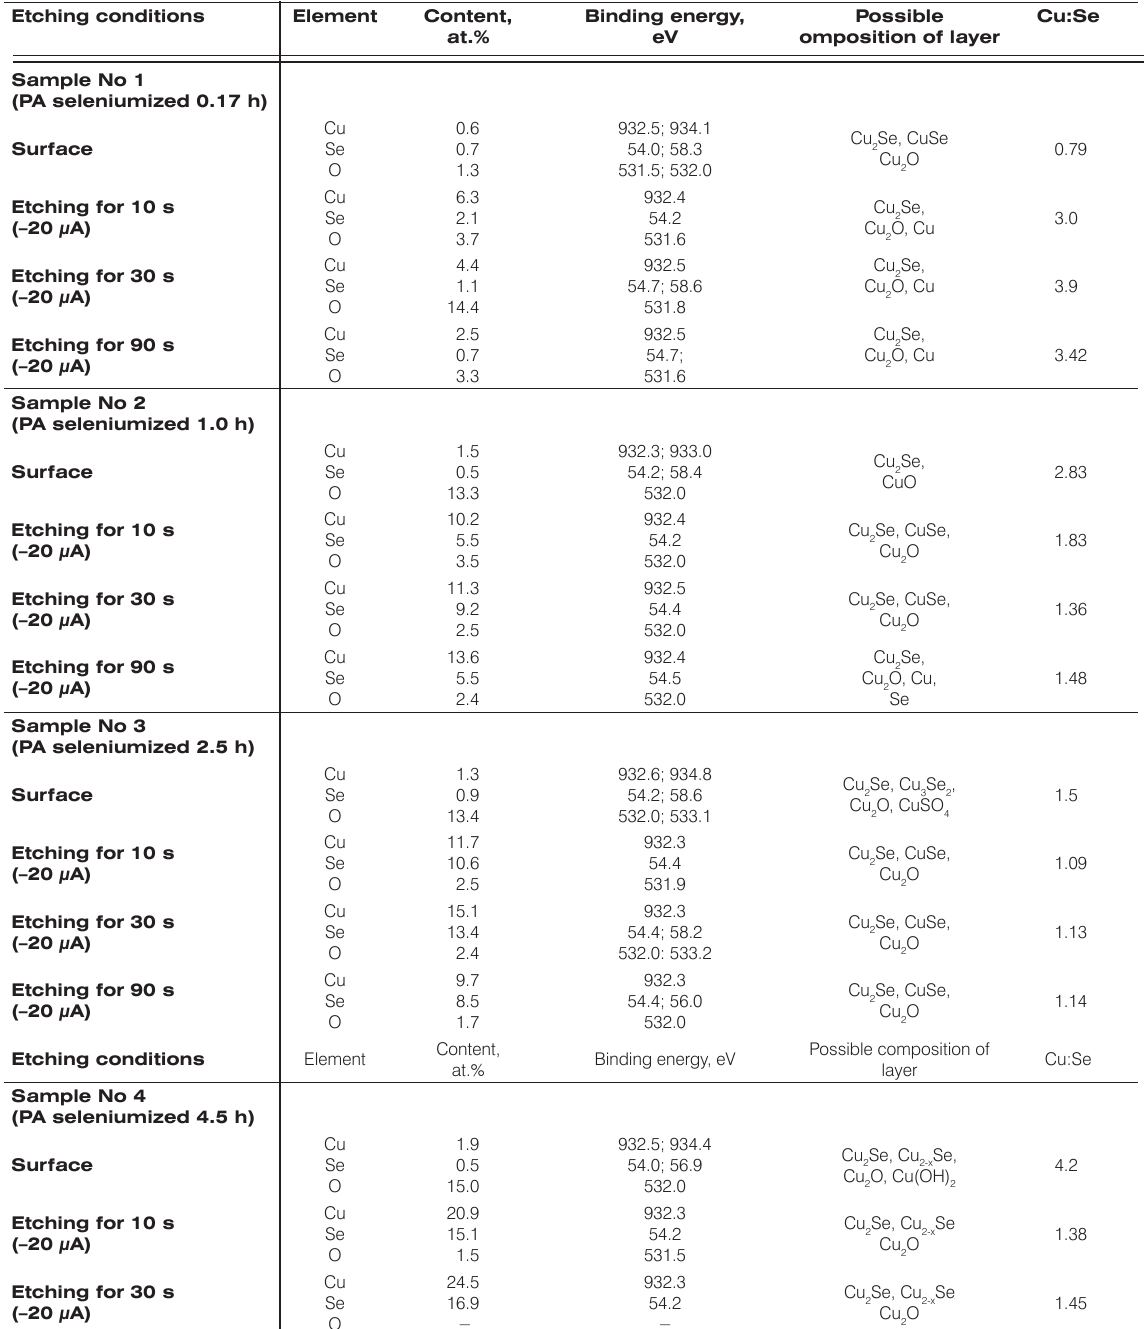
Se layers formed by a sorption-diffusion method on PA films x